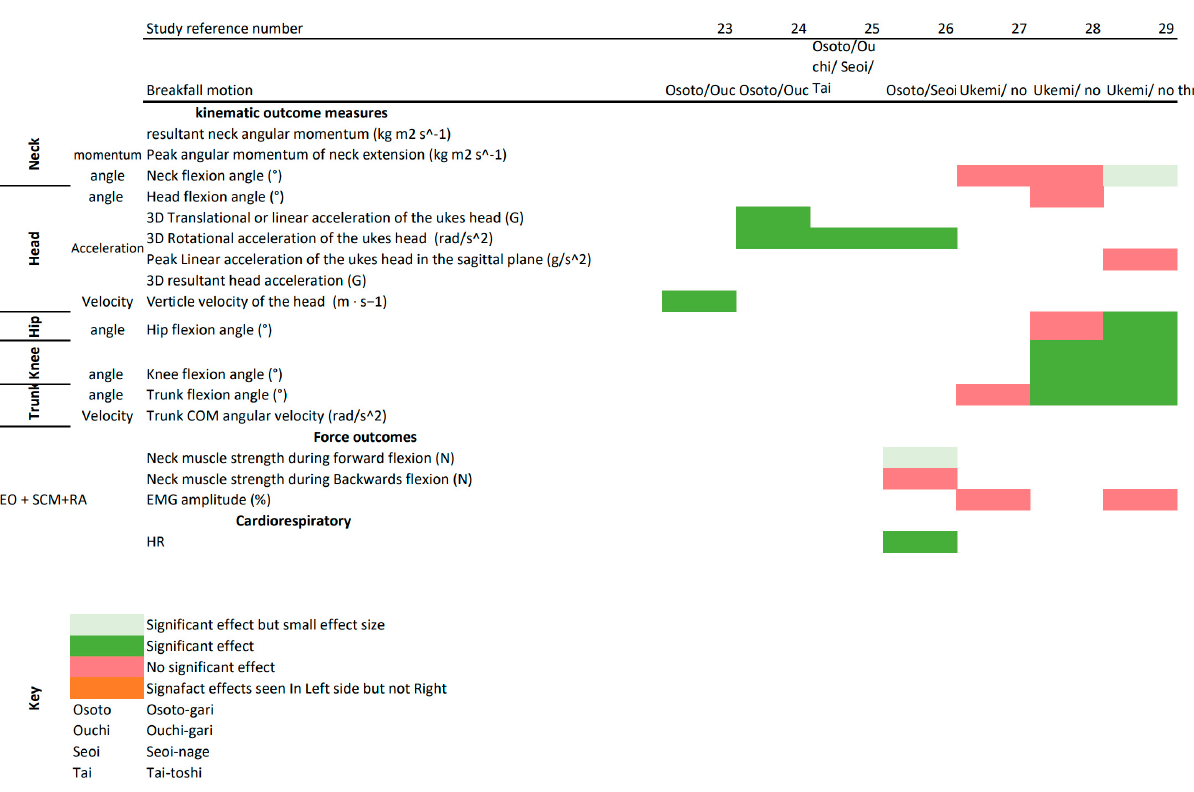
Figure A1. outcome groupings. Figure A1. Outcome groupings.